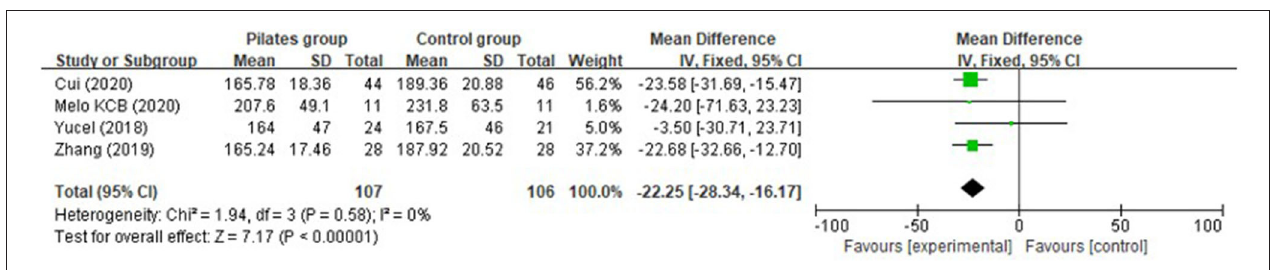
FIGURE 4 | Meta-analysis and forest plot for post-prandial blood glucose. diabetes (MD = − 15.82 mg/dL, 95% CI: [ − 24.46, − 7.18] mg/dL, P = 0.0003, I 2 = 92%), and the effect sizes of 8 and 12-week interventions were pooled from one study (Zhang and Chen,